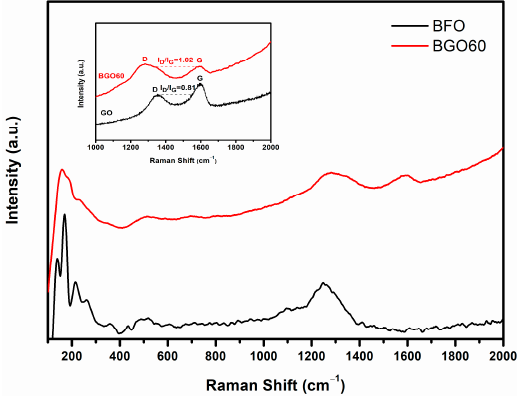
Figure 4. Raman spectra of BFO and BGO60. Inset shows D band and G band of BGO60 and GO. X-ray photoelectron spectroscopy (XPS) is performed to analyze the surface chemical compositions and the oxidation state of the elements presented in the as-synthesized BFO and BGO60 samples. The full survey spectrum of the BGO60 sample is shown in Figure 5, the dominant peaks can be assigned to Bi 4f, Bi 4d, Bi 5d, Fe 2p, O 1s, and C 1s core level states, the weak peaks are attributed to Fe 2p and Bi 4s. The binding energy was obtained through correction of charging effect by C 1s peak at 284.8 eV. Figure 6a,b show the high resolution spectra of O 1s and Fe 2p core level of BFO. The binding energy of O 1s in BFO appears at 530.2, 532.1, and 533.4 eV corresponding to lattice oxygen, chemisorbed oxygen and physically absorbed oxygen, respectively. The doublet peak at 711.0 eV and 724.6 eV for BFO can be corresponding to Fe 2p 3/2 and Fe 2p 1/2 core level states arising from the spin-orbital splitting, respectively. The spin orbit splitting energy of Fe 2p 3/2 and Fe 2p 1/2 is calculated to 13.6 eV, which is consistent with the value of Fe 3+ in the literature [41]. In addition, a satellite peak appears at 719.0 eV between Fe 2p 3/2 orbit and Fe 2p 1/2 orbit, about 8 eV above the Fe 2p 3/2 orbit, and this further confirms the +3 valence state of the Fe iron in the as-synthesized BFO sample [42,43]. As shown in Figure 6c, the binding energies of O1s in BGO60 composite are observed at 530.3, 532.2, and 533.6 eV for the positions of lattice oxygen, chemisorbed oxygen and physically absorbed oxygen, respectively. Compared with BFO (Figure 6b), the peak positions of Fe 2p 3/2 , Fe 2p 1/2 and the satellite peak in BGO60 composite are shifted towards higher binding energy, located at 711.4, 724.9 and 719.4 eV (Figure 6d), the Fe 2p slight shift might be due to the interaction with many oxygen containing groups in the RGO network. At the same time, O1s of BGO60 is also slightly shifted to high binding energy. It should attribute to the higher amount of C-O bonds in BGO60. As shown in Figure 6e, the C 1s for GO is deconvoluted into four peaks at 248.6, 285.4, 287.1, and 289.0 eV, corresponding to C-C, C-H, C-O and COOH/C=O groups, respectively. The binging energy of C 1s for BGO60 (Figure 6f) located at 284.5, 285.3, 286.3 and 288.3 eV, which could be assigned to C-C, C-H, C-O, and COOH/C=O groups, respectively. Compared with GO, the relative area percentage of